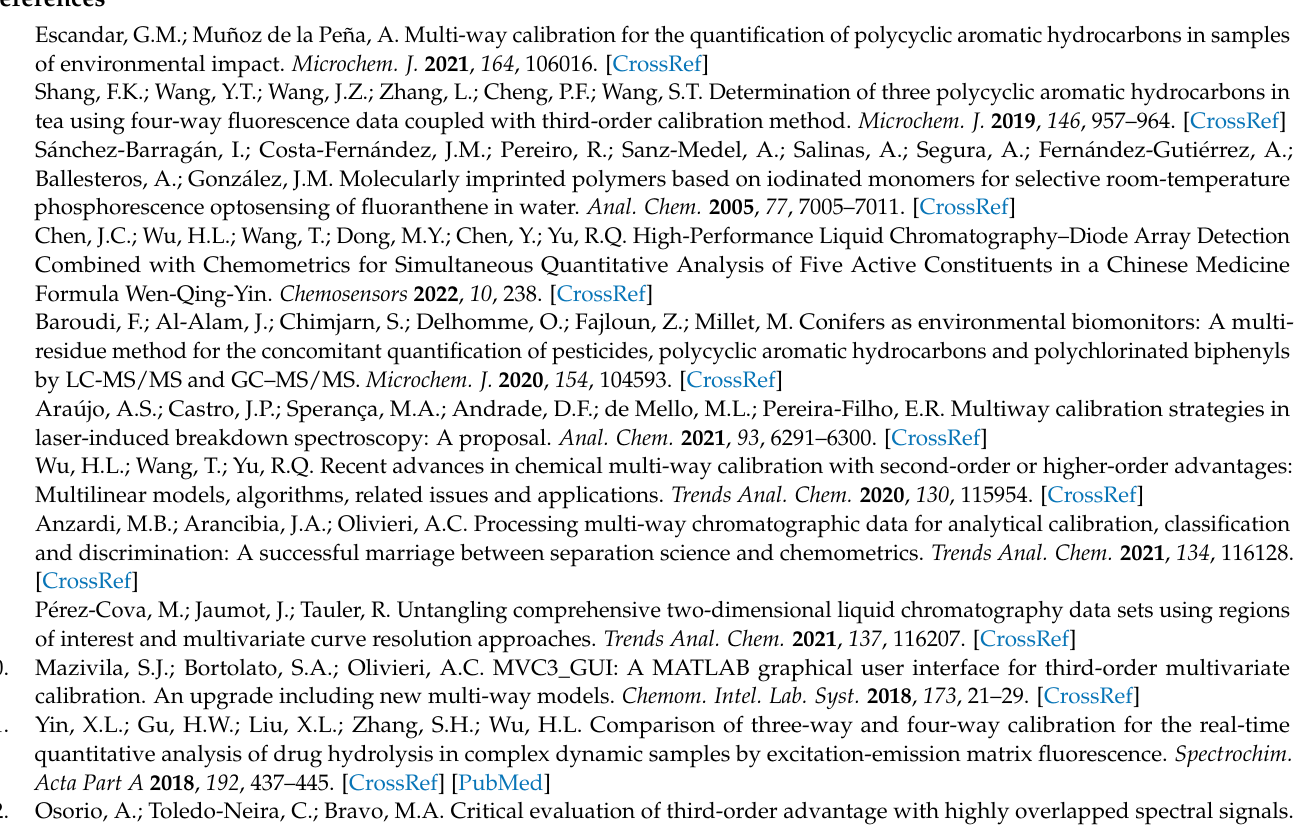
noise; Table S2: The influence of heteroscedastic noise levels on correlation coefficients, root-mean- square errors of prediction (RMSEPs) and k values predicted by PARAFAC, AQLD and SWAQLD, respectively, for simulated four-way data; Table S3: The influence of factor numbers (N) on correlation coefficients, RMSEPs and k values predicted by PARAFAC, AQLD and SWAQLD, respectively, for simulated four-way data with α homo = 2%; Table S4: The influence of factor numbers (N) on correla- tion coefficients, RMSEPs and k values predicted by PARAFAC, AQLD and SWAQLD, respectively, for simulated four-way data with α heter =